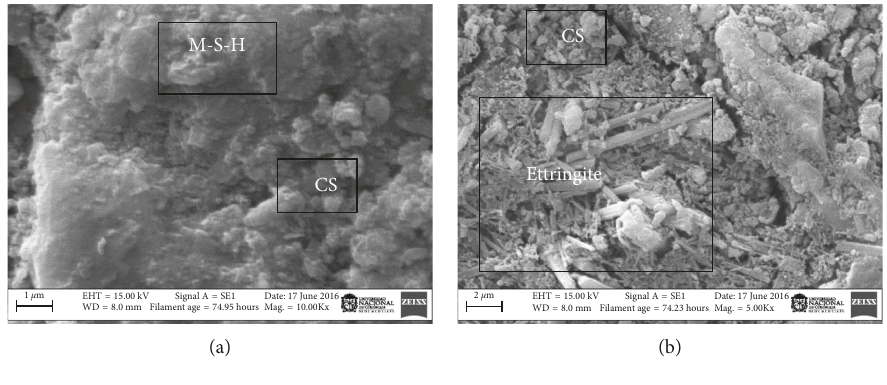
Figure 13: ITZ of (a) PEC5S-0 and (b) PEC5S-10.